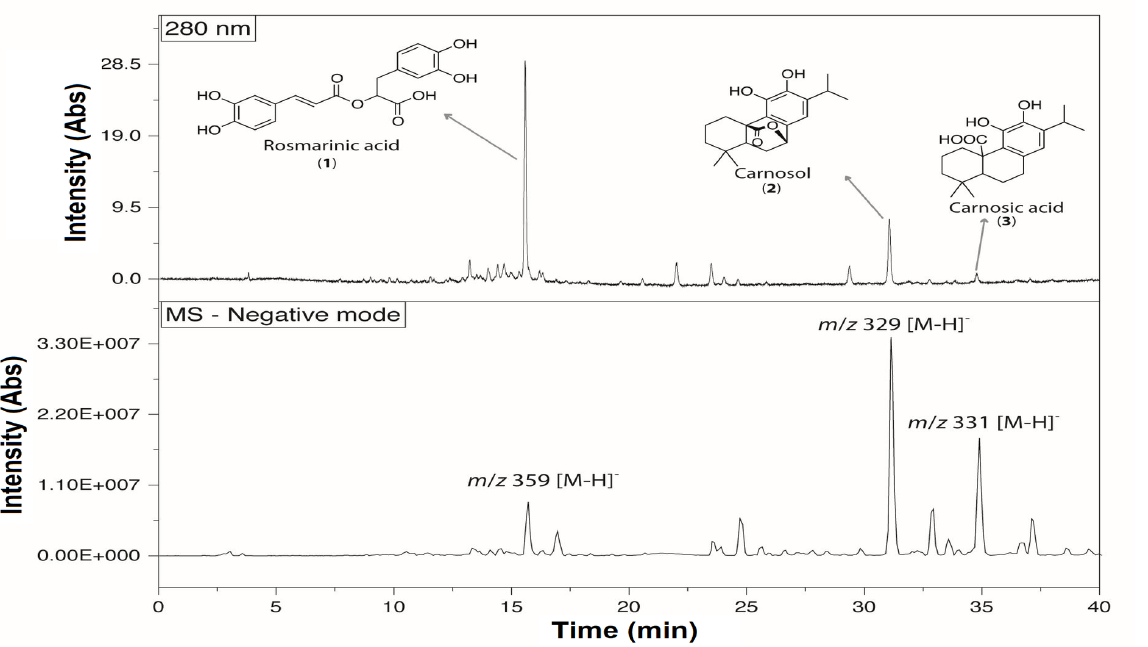
Figure 2. Chromatogram (280 nm) and Total Ion Chromatogram (TIC) obtained in the negative ionization mode of the R. officinalis hydroethanolic